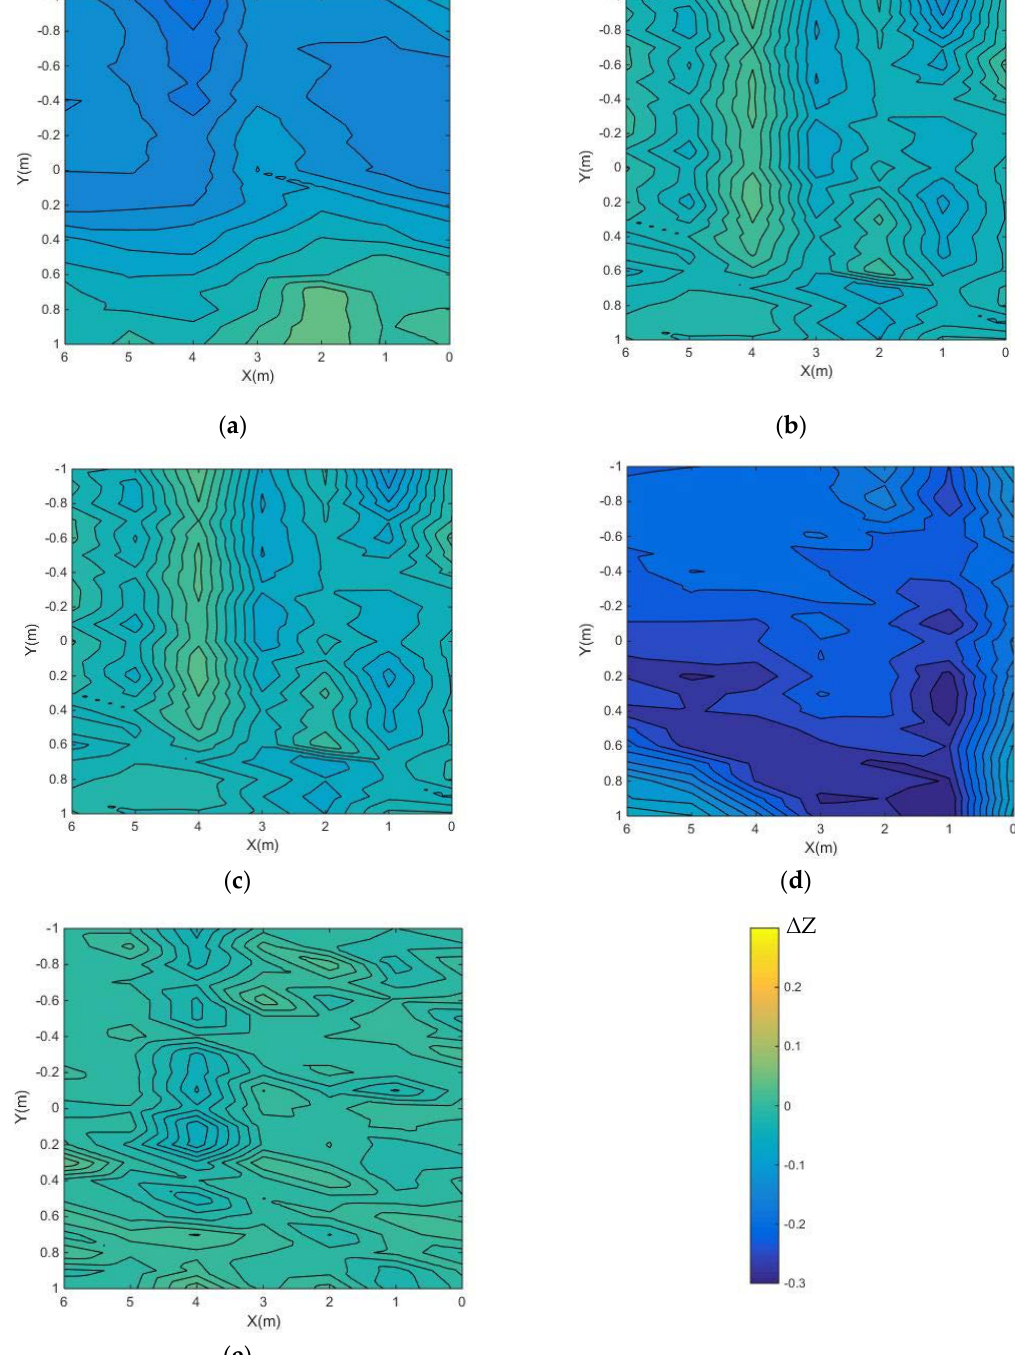
Figure 8. Erosion and accretion maps of the monitored area: ( a ) comparison between t = 0 min and t = 1 200 min; ( b ) comparison between t = 1 200 min and t = 1 590 min; ( c ) comparison between t = 1 590 min (A.1) and t = 1 590 min (A.2); ( d ) comparison between t = 1 590 min (A.2) and t = 2 790 min; ( e ) comparison between t = 1 590 min (A.1) and t = 2 790 min. Table 3. Erosion and accretion volumes at the monitored area.